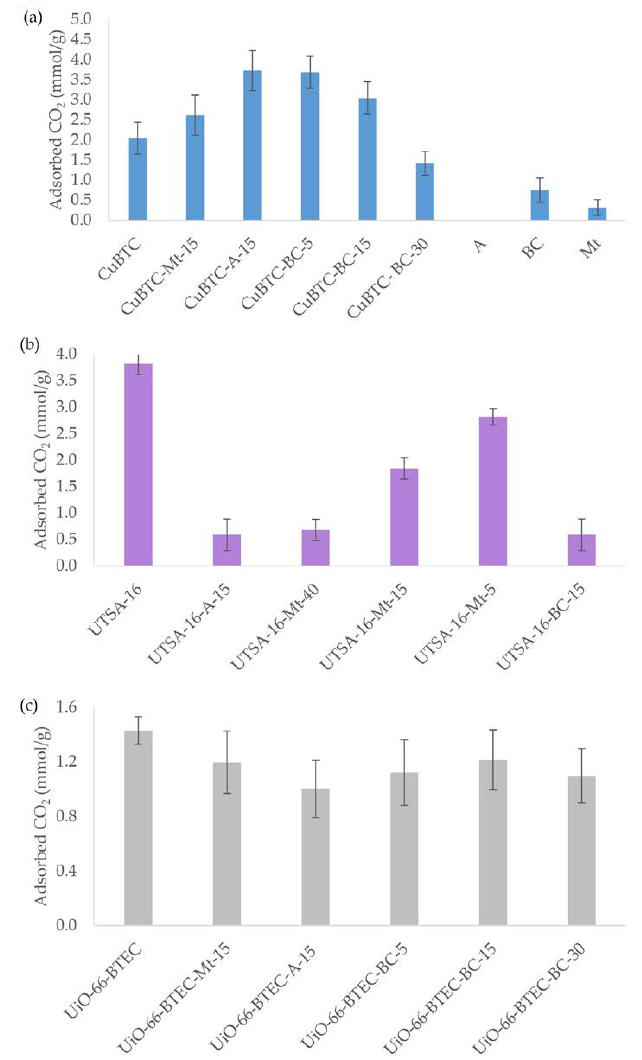
Figure 11. CO 2 adsorption using ( a ) CuBTC and CuBTC-composites containing aerosil (CuBTC-A-15), montmorillonite (CuBTC-Mt-15), and CuBTC-composites containing different amounts of biochar (CuBTC-BC-5, CuBTC-BC-15, and CuBTC-BC-30, respectively), ( b ) UTSA-16 and UTSA-16-composites containing aerosil (UTSA-16-A-15), biochar (UTSA-16-BC-15), and UTSA-16-composites containing dif- ferent amounts of montmorillonite (UTSA-16-Mt-5, UTSA-16-Mt-15, and UTSA-16-Mt-40, respectively), ( c ) UiO-66-BTEC and UiO-66-BTEC-composites containing aerosil (UiO-66-BTEC-A-15), montmorillo- nite (UiO-66-BTEC-Mt-15), and UiO-66-BTEC-composites containing different amounts of biochar (UiO- 66-BTEC-BC-5, UiO-66-BTEC-BC-15, and UiO-66-BTEC-BC-30, respectively).